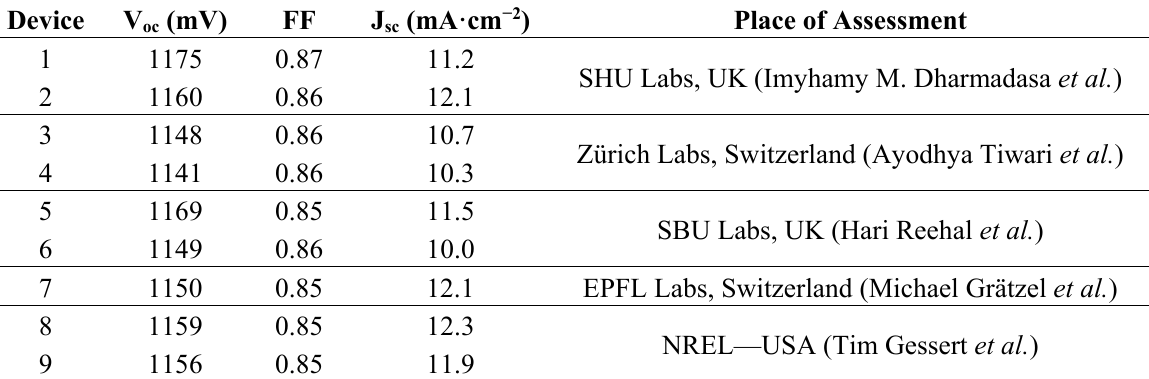
Table 2. The summary of solar cell parameters as measured in five different laboratories for